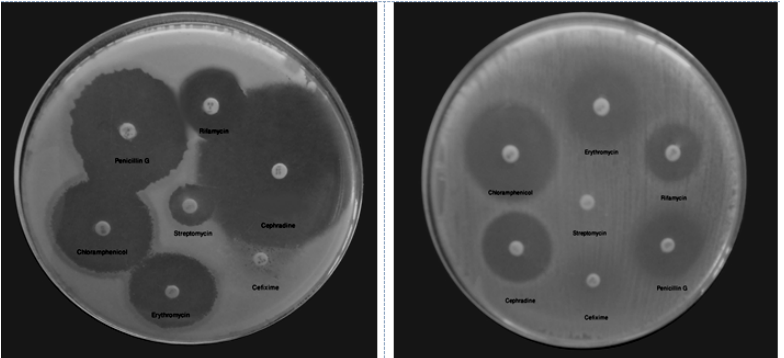
Fig. 4. Photograph of antibiotic susceptibility testing (AST) of L. coryniformis subsp. torquens MTi1 and L. coryniformis